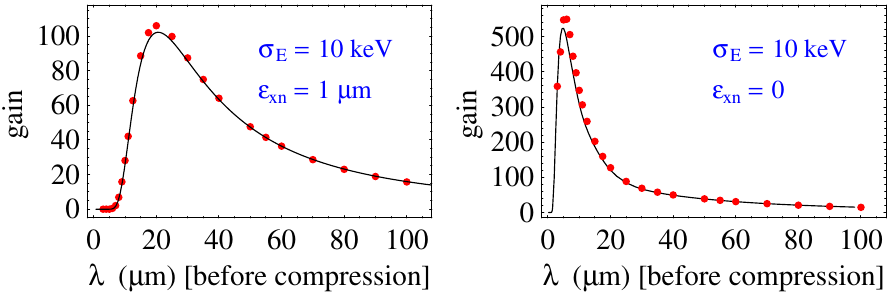
FIG. 8. (Color) Gain curves through FERMI L1 and BC1 as determined from linear theory (solid line) and numerical solutions of the Vlasov equation, with nonvanishing (left picture) and vanishing (right picture) transverse emittance. Space-charge was included in L1 but not in BC1 and calculated based on the beam sizes resulting from (cid:2)"